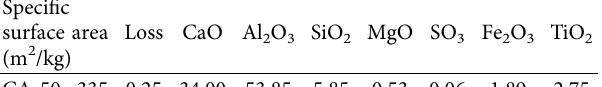
Table 2: Specific surface area and chemical composition analysis of aluminate